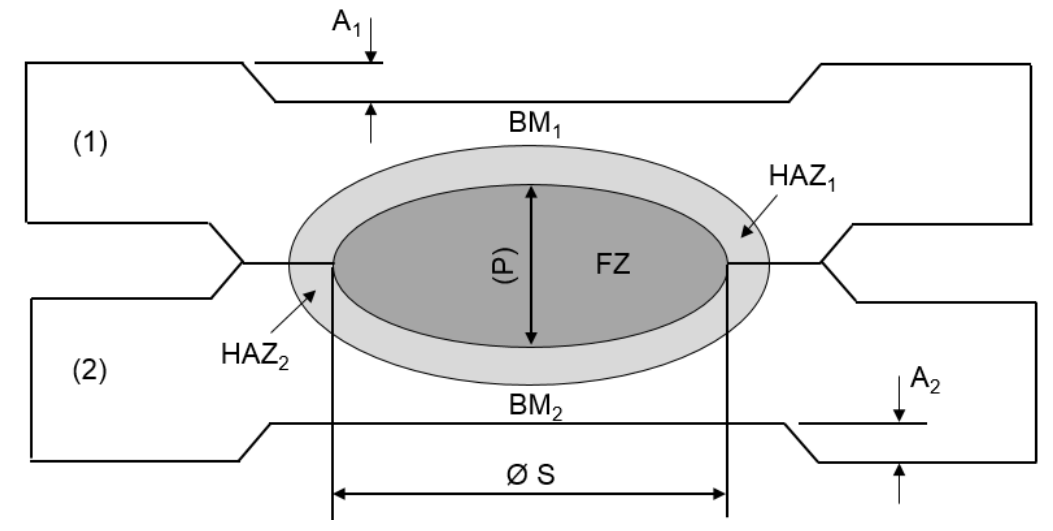
Figure 4. Schematic drawing of a spot welding joint geometry.